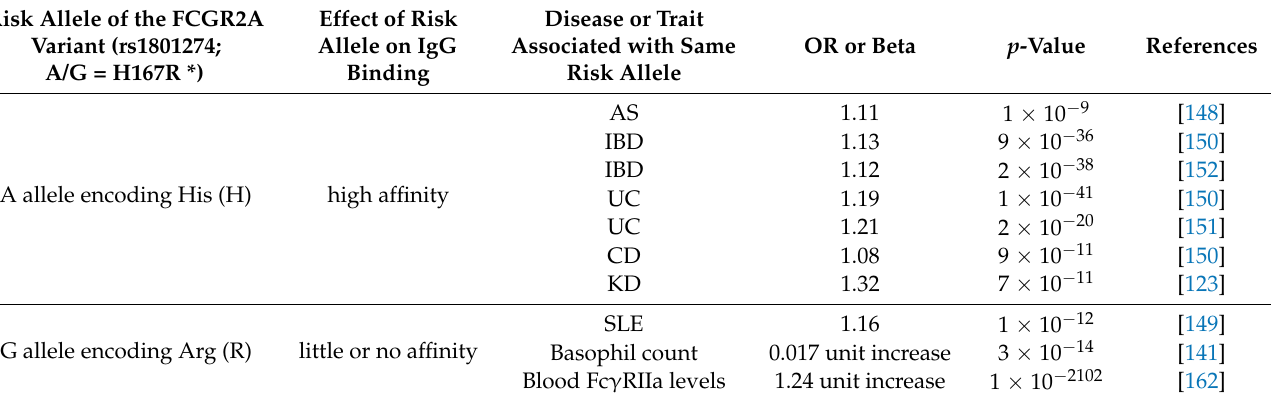
Table 6. Different effects of the risk allele of FCGR2A variant